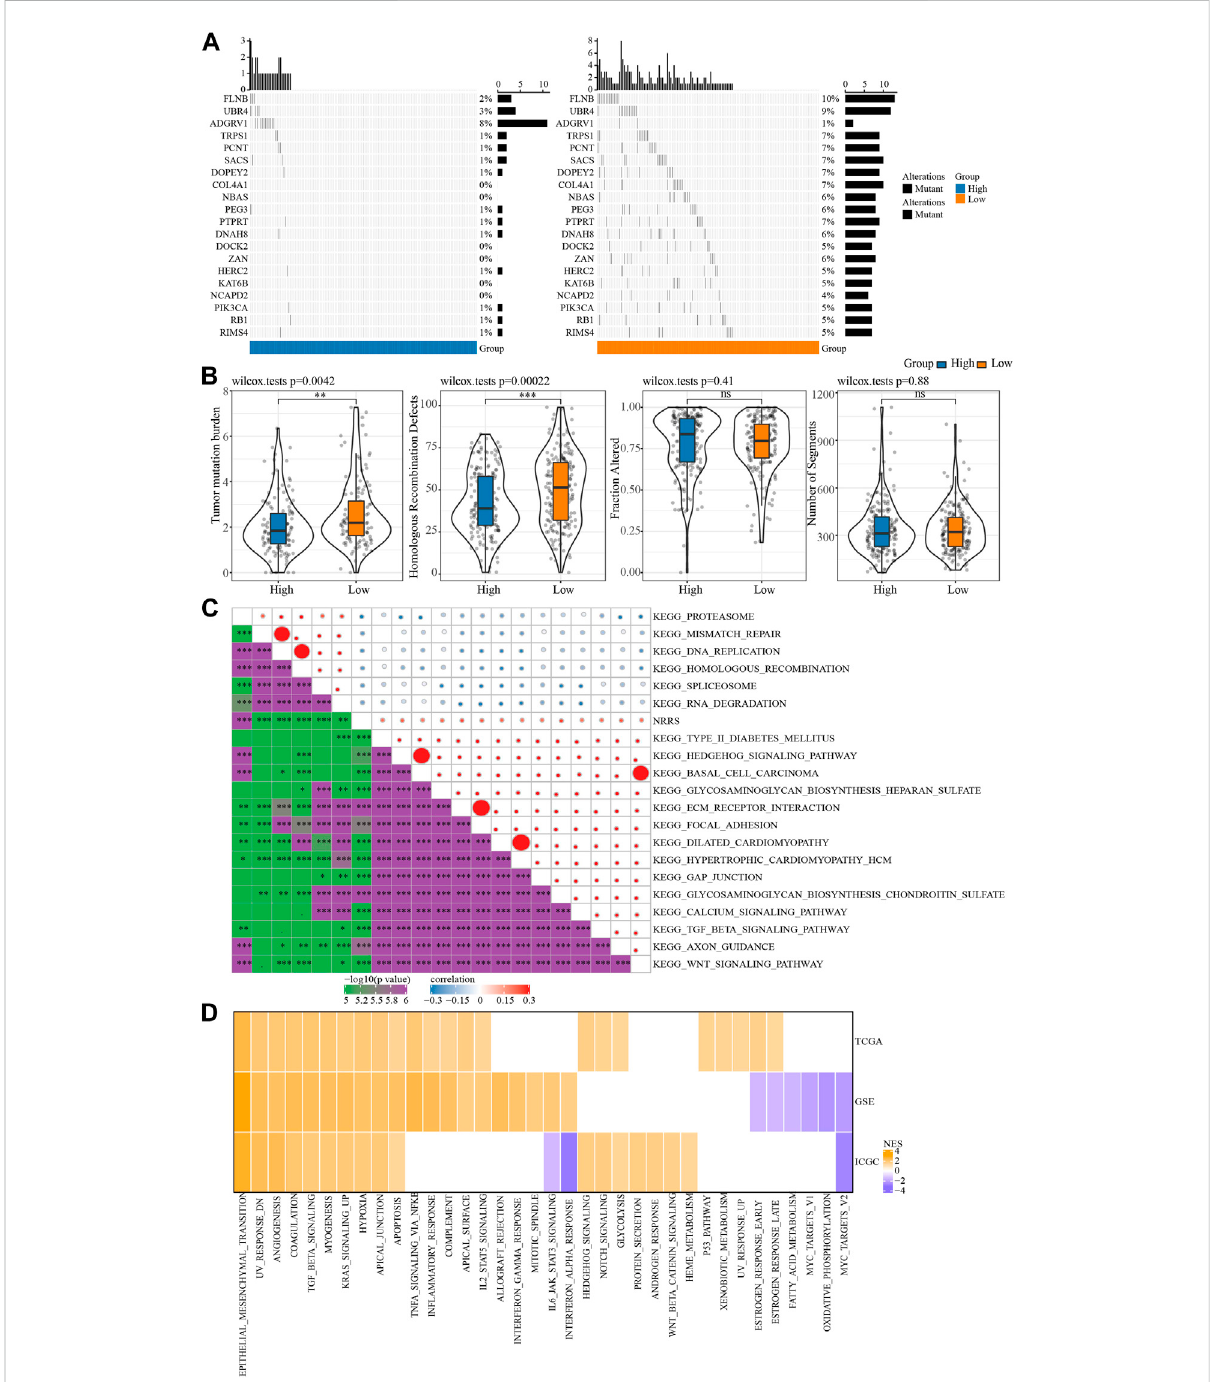
FIGURE 5 SNV and biological characteristics of NRRS model. (A) SNV in high-risk and low-risk groups. (B) TMB, homologous recombination defect, fraction altered, number of segments of high-risk group and low-risk group. (C) The correlation between NRRS and tumor biological pathway. (D) The high-risk group compared with the low-risk group in different pathways of NESs. * p < 0.05, ** p < 0.01, *** p < 0.001, **** p <